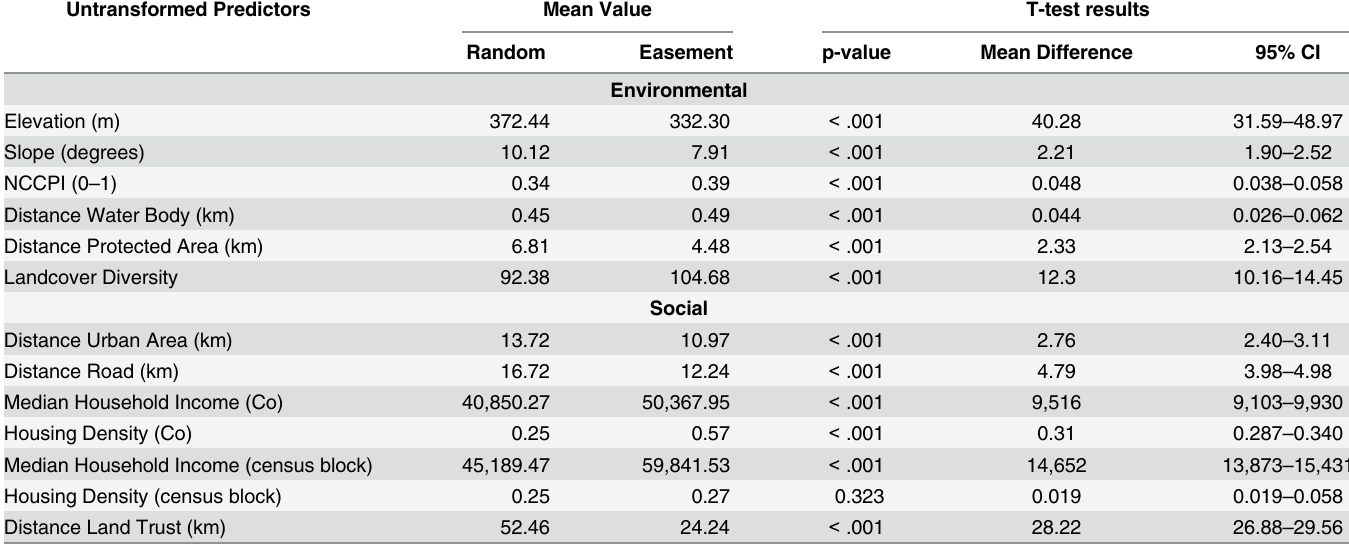
Table 2. Comparison of mean predictor variable values within conservation easements versus random locations in unprotected areas within the Appalachian